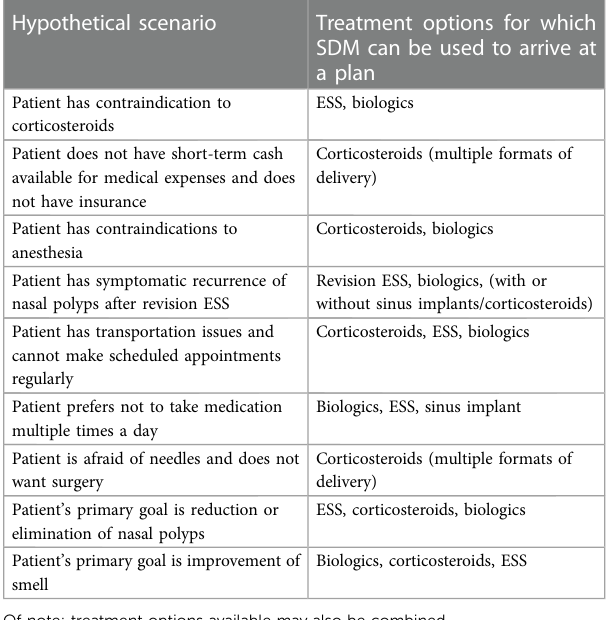
TABLE 3 Example hypothetical scenarios and respective treatment options available for which shared decision-making may be utilized